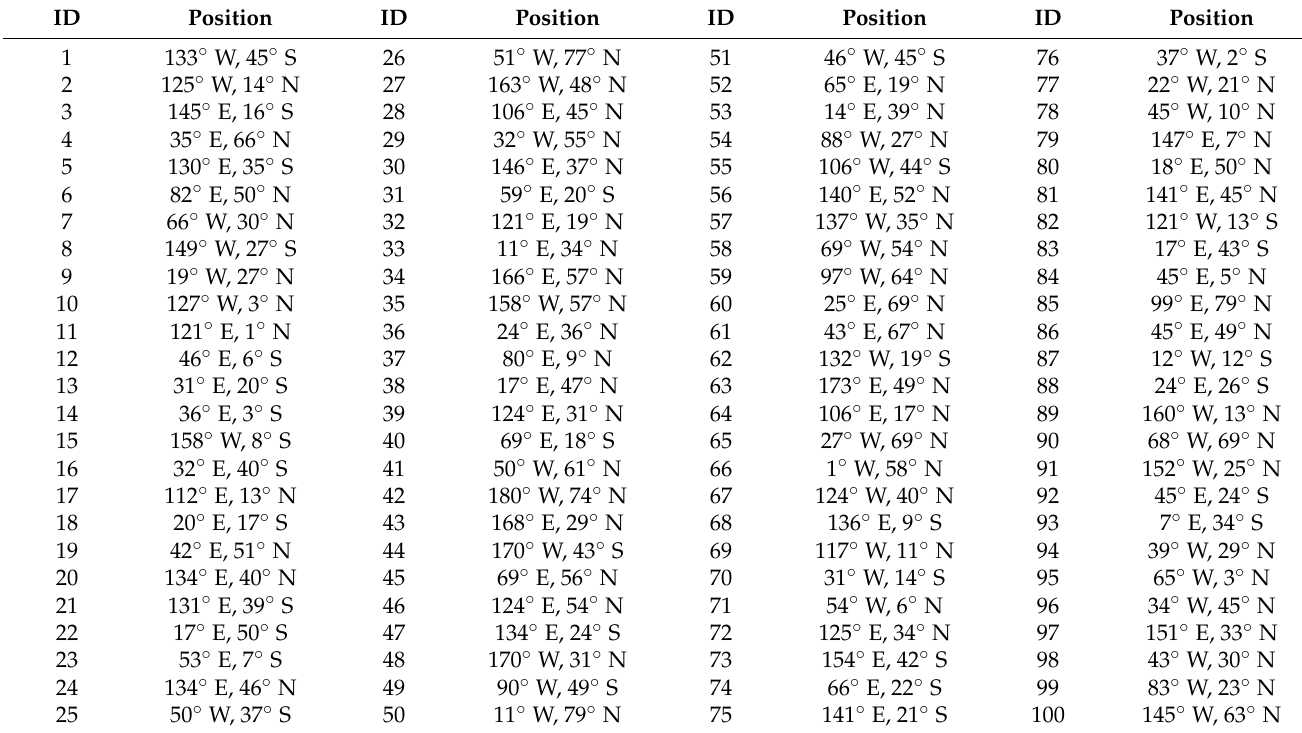
Table A1. Target position distribution of the point target observation